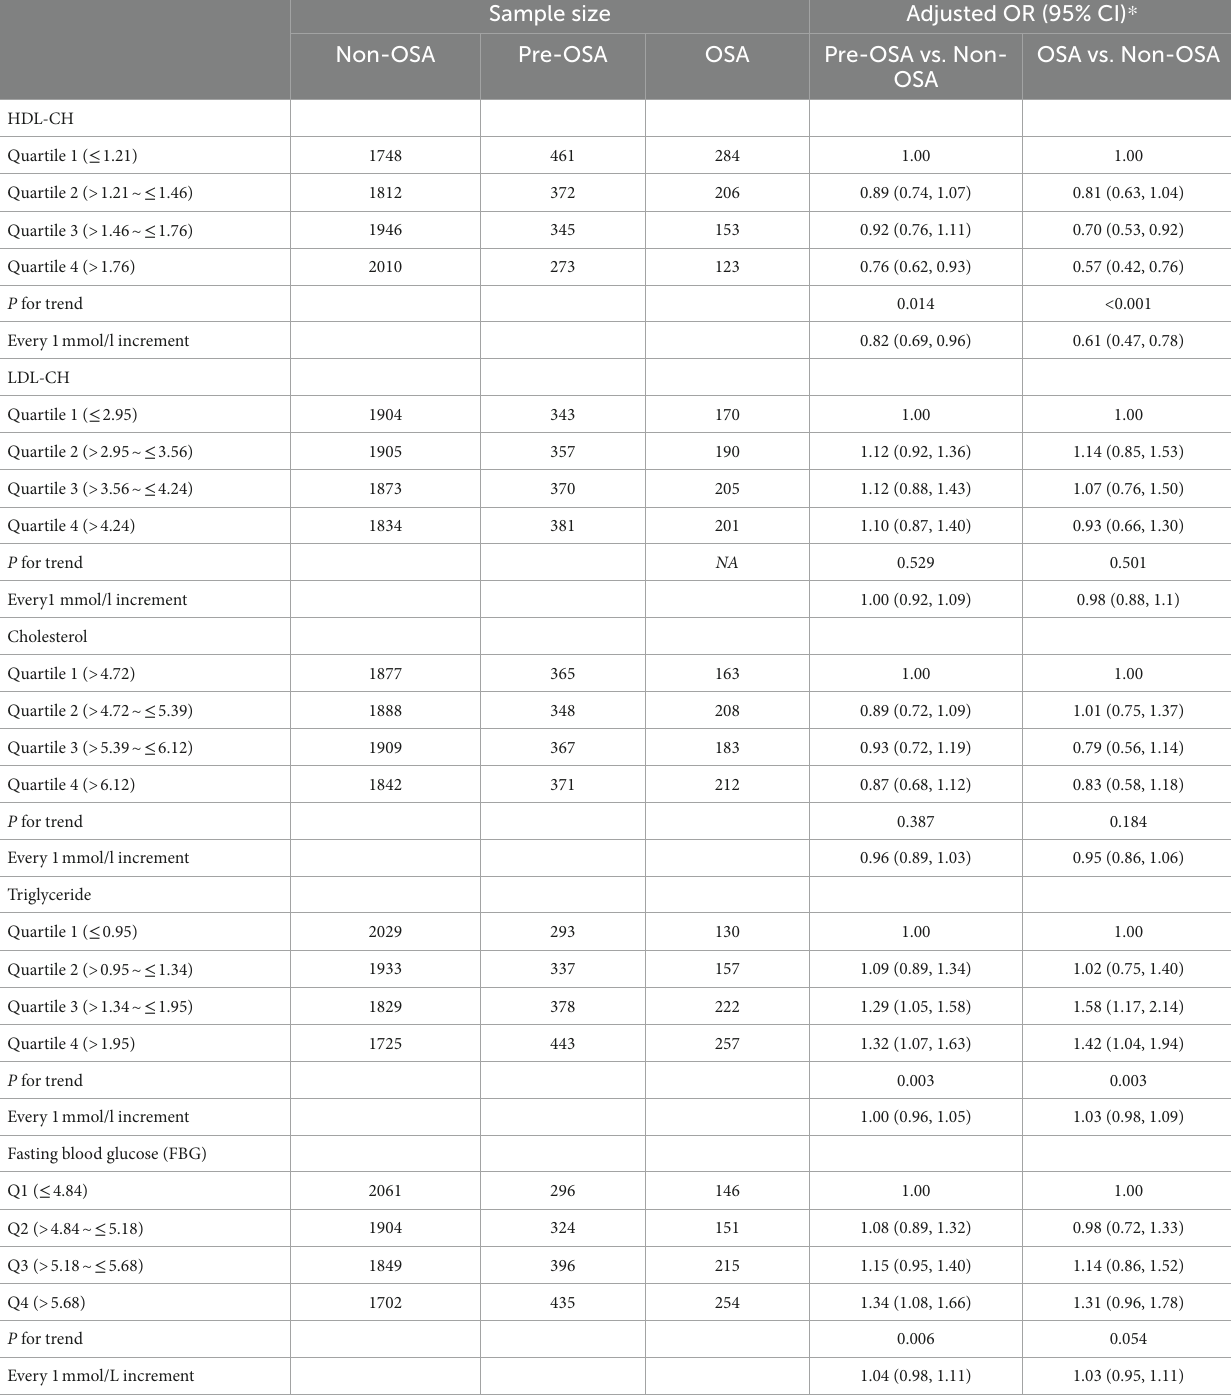
TABLE 4 Association between glycolipid biomarkers and OSA risk after excluding participants with COPD and